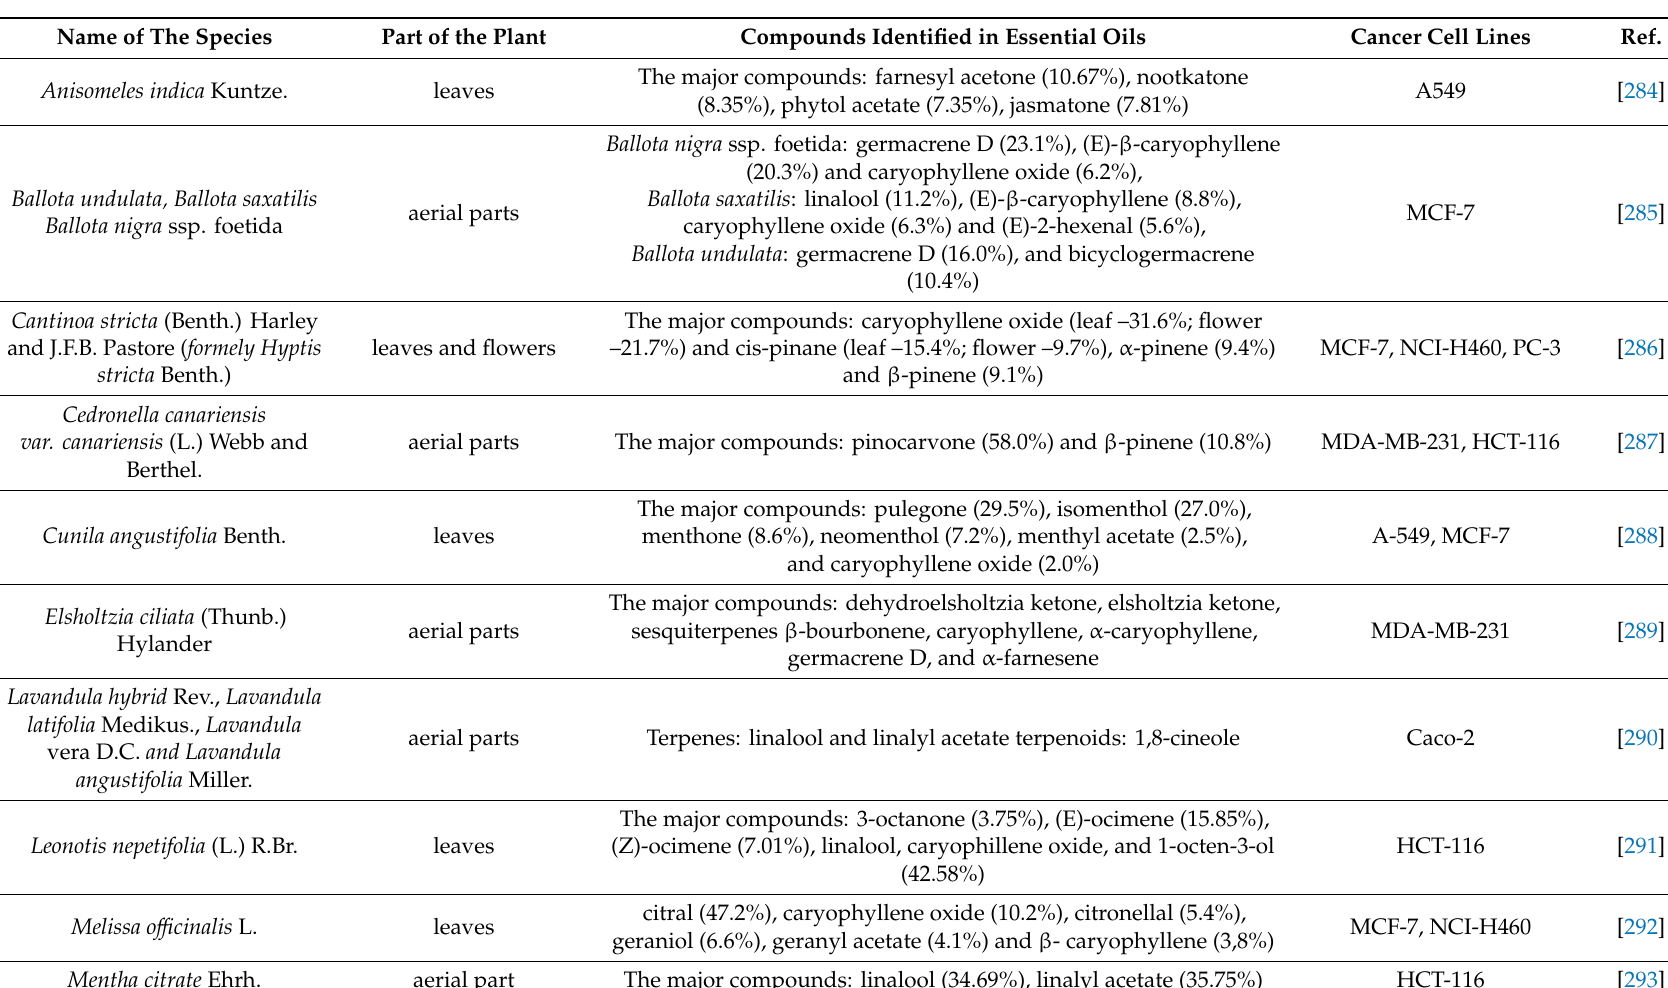
Table 3. Cytotoxic properties of selected essential oils from the Lamiaceae family against lung, colon, breast, and prostate cancer